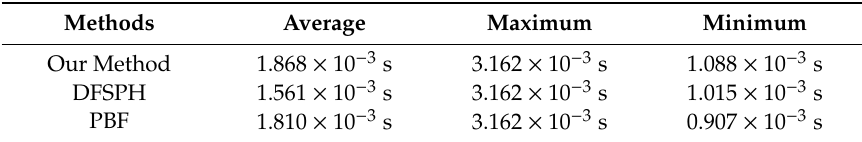
Figure 6. The comparison of incompressibility between DFSPH and our SPH models. The experimental scene is dam break, and the data are taken from the first 2000 time steps. ( a ) The maximum density of fluid particles in each time step. The orange and the blue curves in ( a ) are the maximum densities of DFSPH method and our method, respectively. ( b ) The average density of fluid particles in each time step. The orange and the blue curves in ( b ) are the average densities of DFSPH method and our method. 3.2. Boundary Handling Simulation Result To validate the unified boundary handling model, various maritime fluid–rigid coupling scenes were designed, including ones coupling fixed objects such as lighthouse and with floating objects